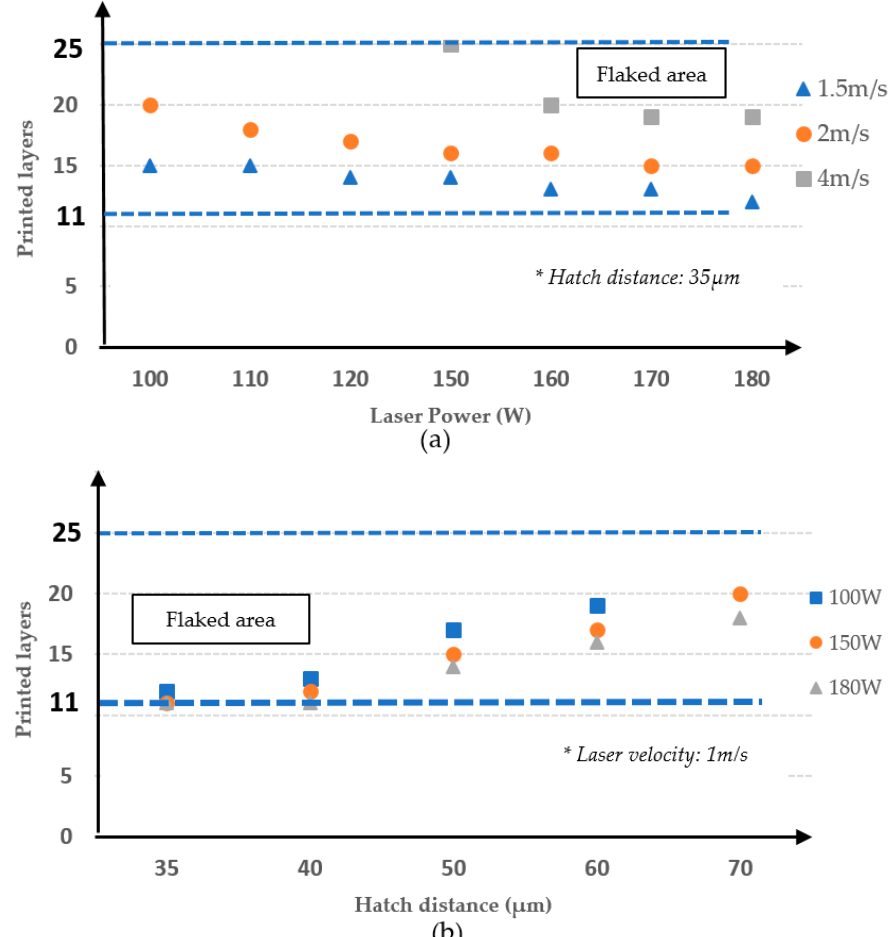
Figure 9. Effects of laser power ( a ), and hatch distance ( b ) on flaking. Figure 9. E ff ects of laser power ( a ), and hatch distance ( b ) on